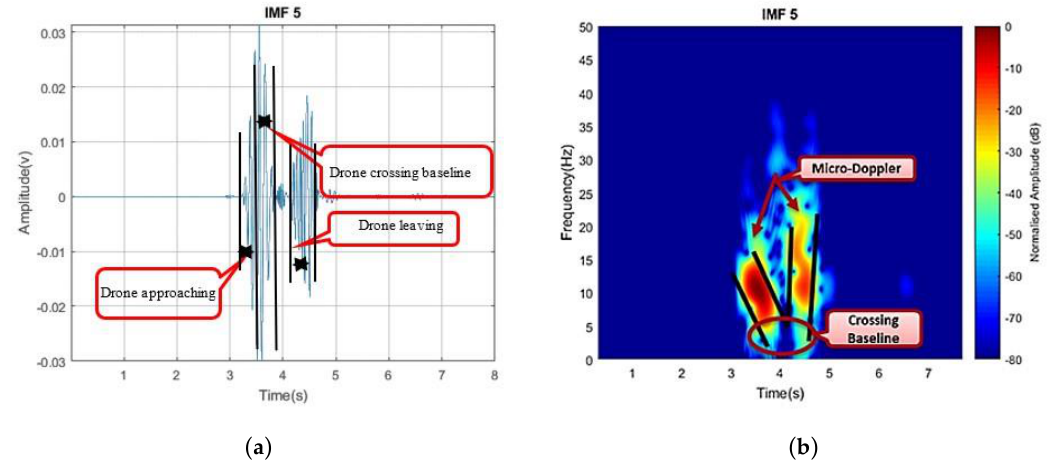
Figure 14. Extracted Doppler Component IMF5 ( a ) time domain and ( b ) its corresponding STFT plot.